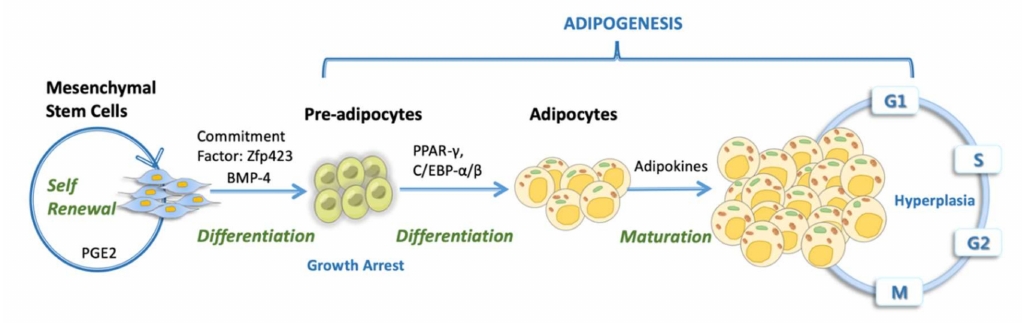
Figure 3. Progression of adipogenic MSCs di ff erentiation and maturation into mature fat cells due to an excess of calories.